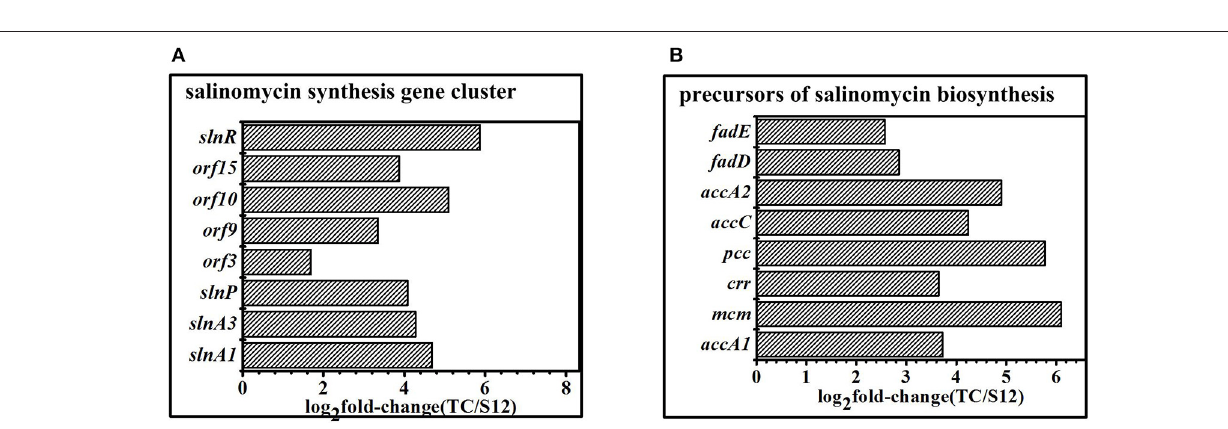
FIGURE 6 | DEGS related to secondary metabolism gene clusters. (A) Expression of genes in salinomycin biosynthesis gene cluster. (B) Expression of genes related to precursors of salinomycin biosynthesis. Histograms show the abundance of the transcripts with significant variations ( p -value < 0.05) discussed in the text. Abundance values are shown in log 2 fold-change (TK/S12). For detail genes expression (see Table S7